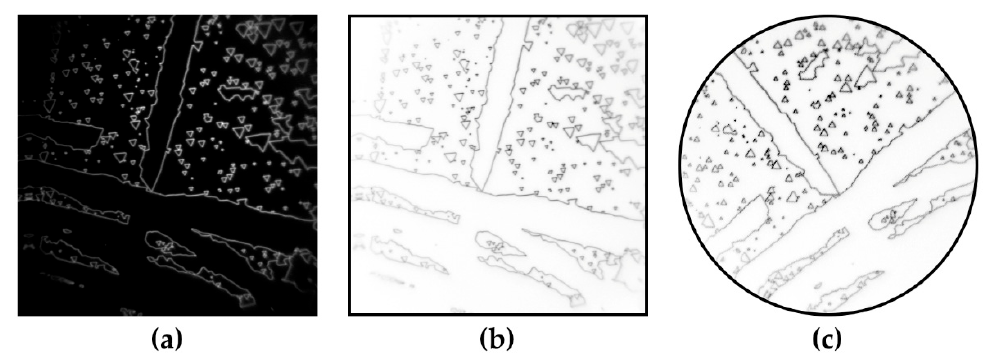
Figure A1. Domain wall images: ( a ) raw image obtained by Cherenkov SHG, ( b ) contrast inverted image, and ( c ) processed image.